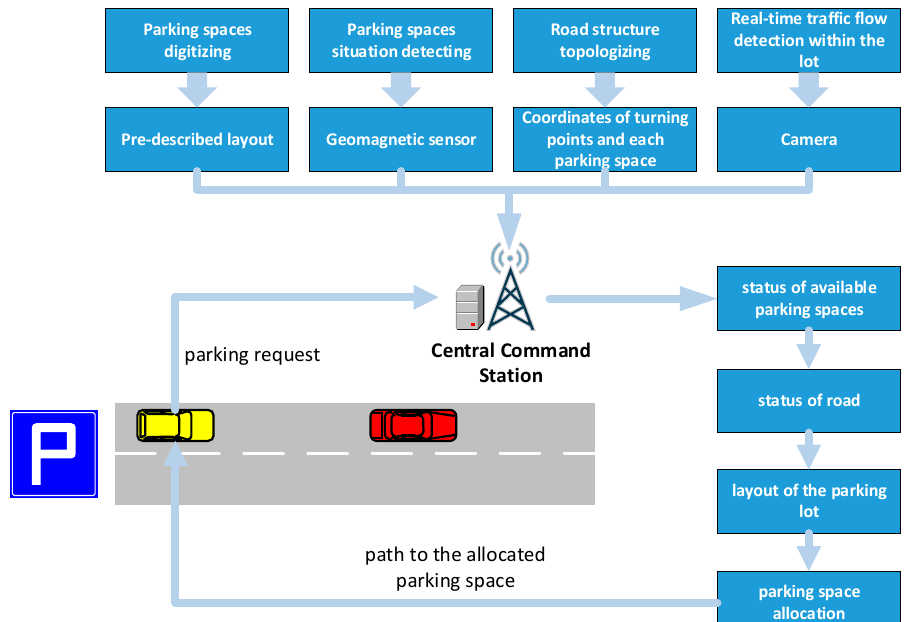
Figure 1. Flowchart of the entire process of parking space allocation and route selection for an autonomous vehicle.